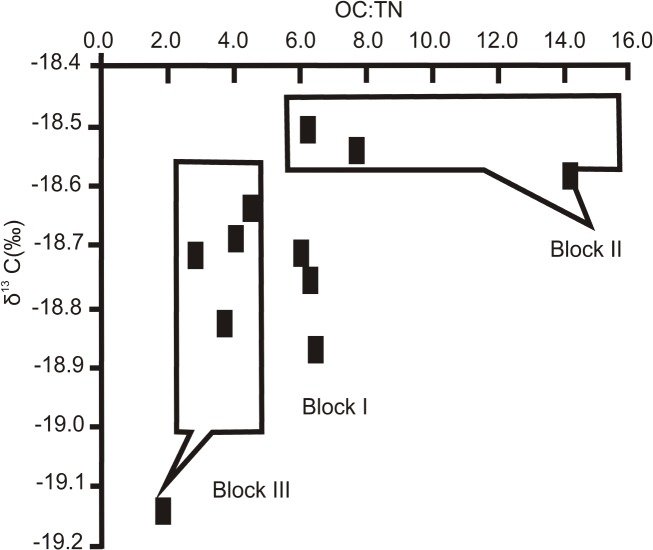
δ13C (‰) values and OC:TN.Relationship between δ13C (‰) values and OC:TN ratios for the three Blocks located on the NW insular slope of Cuba.